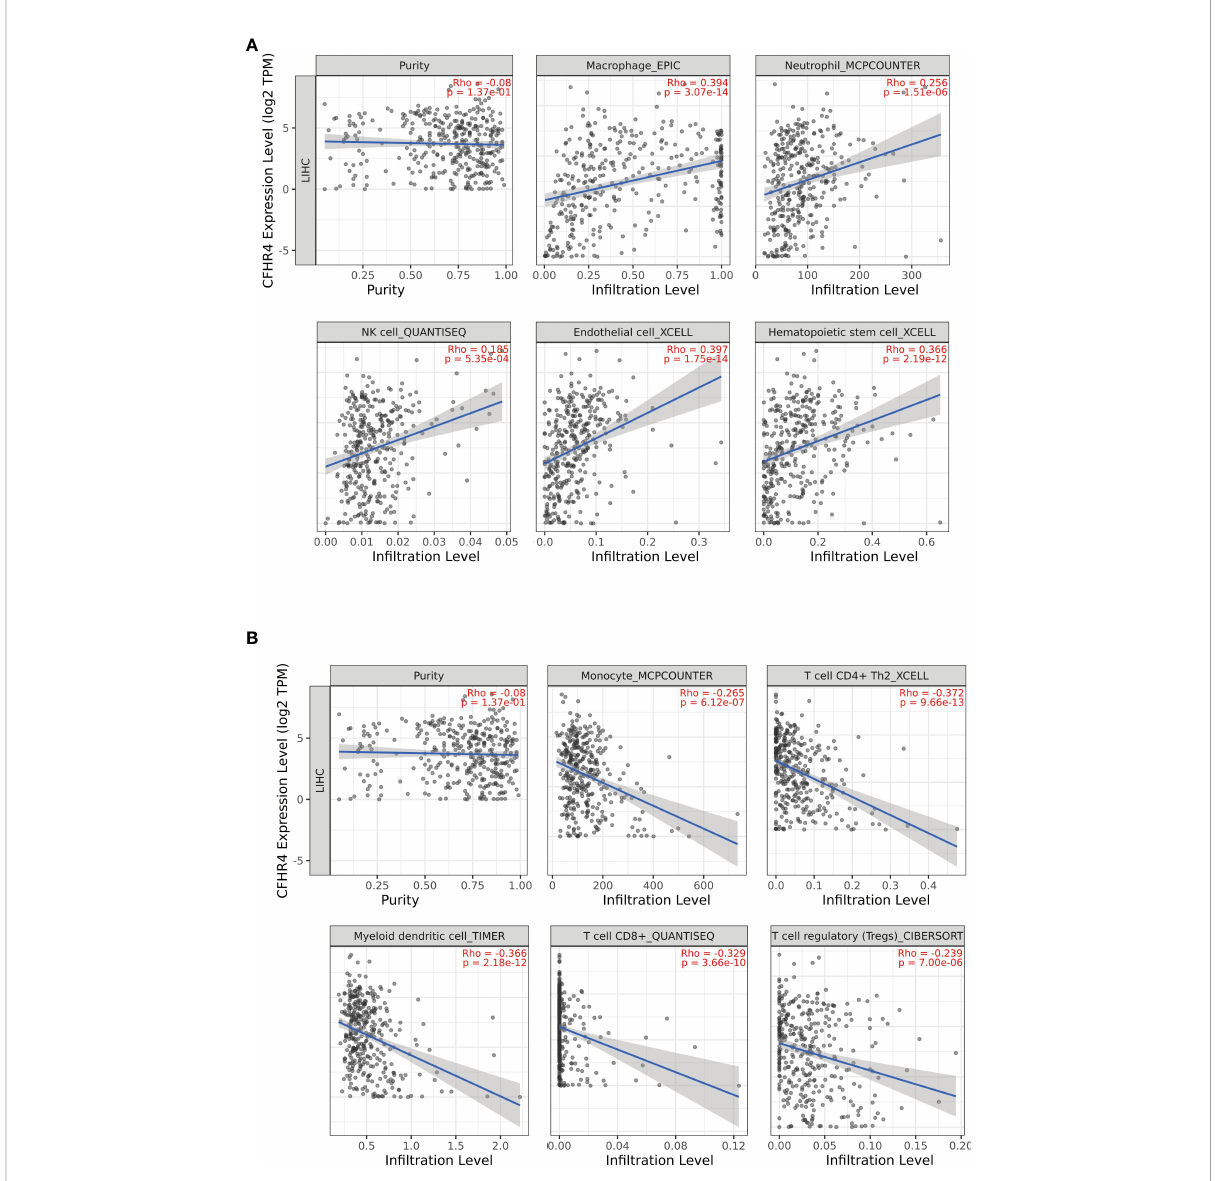
FIGURE 7 Correlations of CFHR4 expression with tumor-in fi ltrating immune (TII) level in HCC. (A) The correlation between CFHR4 expression and the in fi ltrating levels of macrophages cells, neutrophils cells, NK cells, endothelial cells and Hematopoietic stem cells in LIHC. (B) The correlation between CFHR4 expression and the in fi ltrating levels of monocytes cells, CD4+ T cells, myeloid dendritic cells, CD8+ T cells, and regulatory T cells (Tregs) in